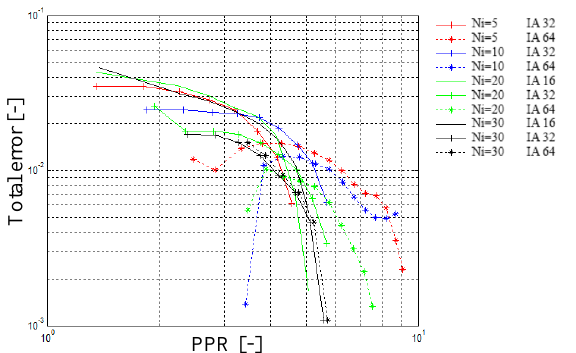
Fig. 3. Influence of seeding density and interrogation area size for PPR.